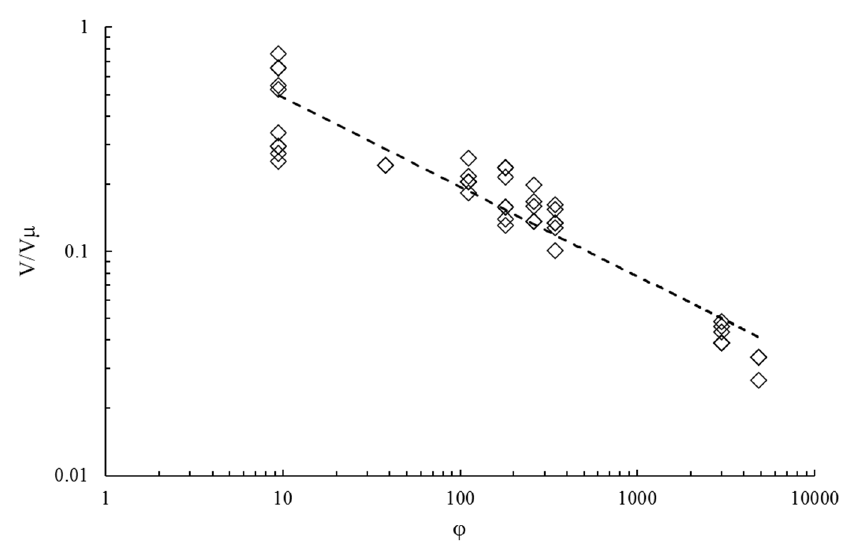
Figure 8. Dimensionless axial jet velocity V / V µ as a function of ϕ with the power law fit V / V µ ~ ϕ − 0.43 for multiple solutions of glycerol volume percentages ranging from 0 to 55%.